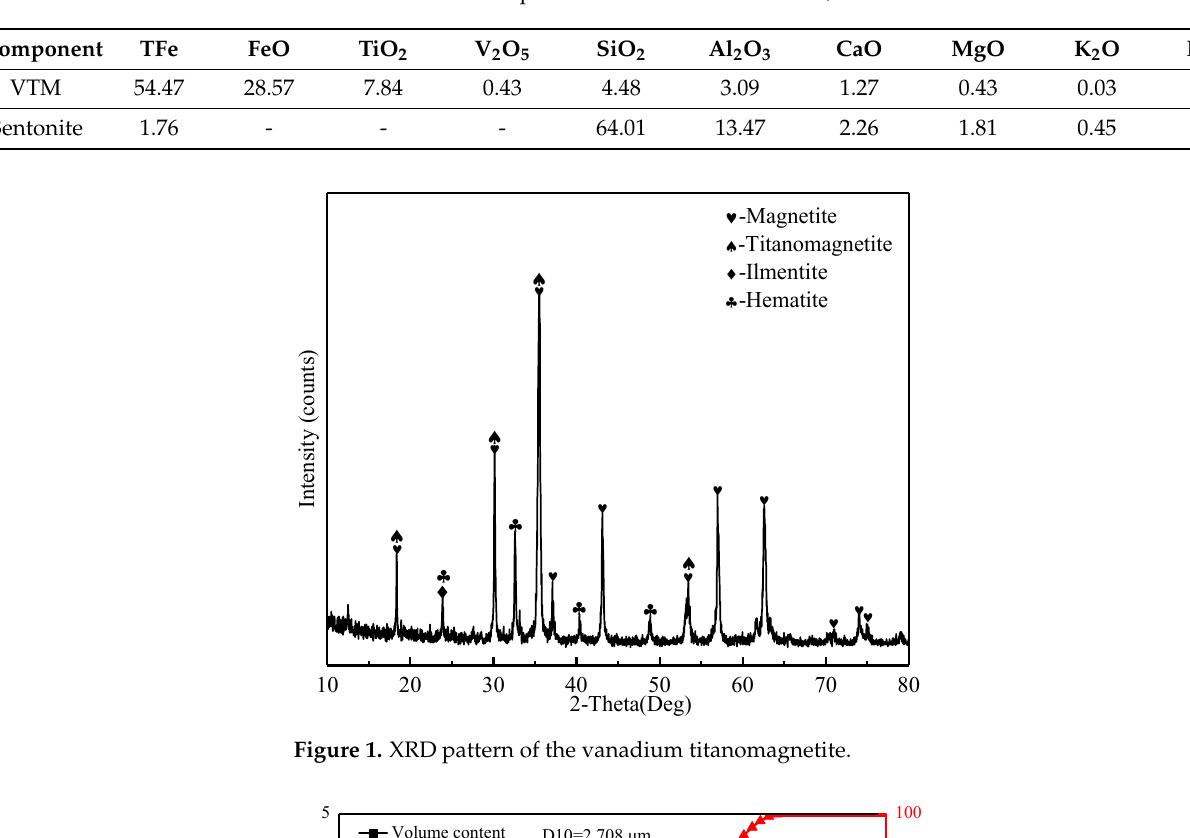
Table 1. Chemical composition of VTM and bentonite/wt%.